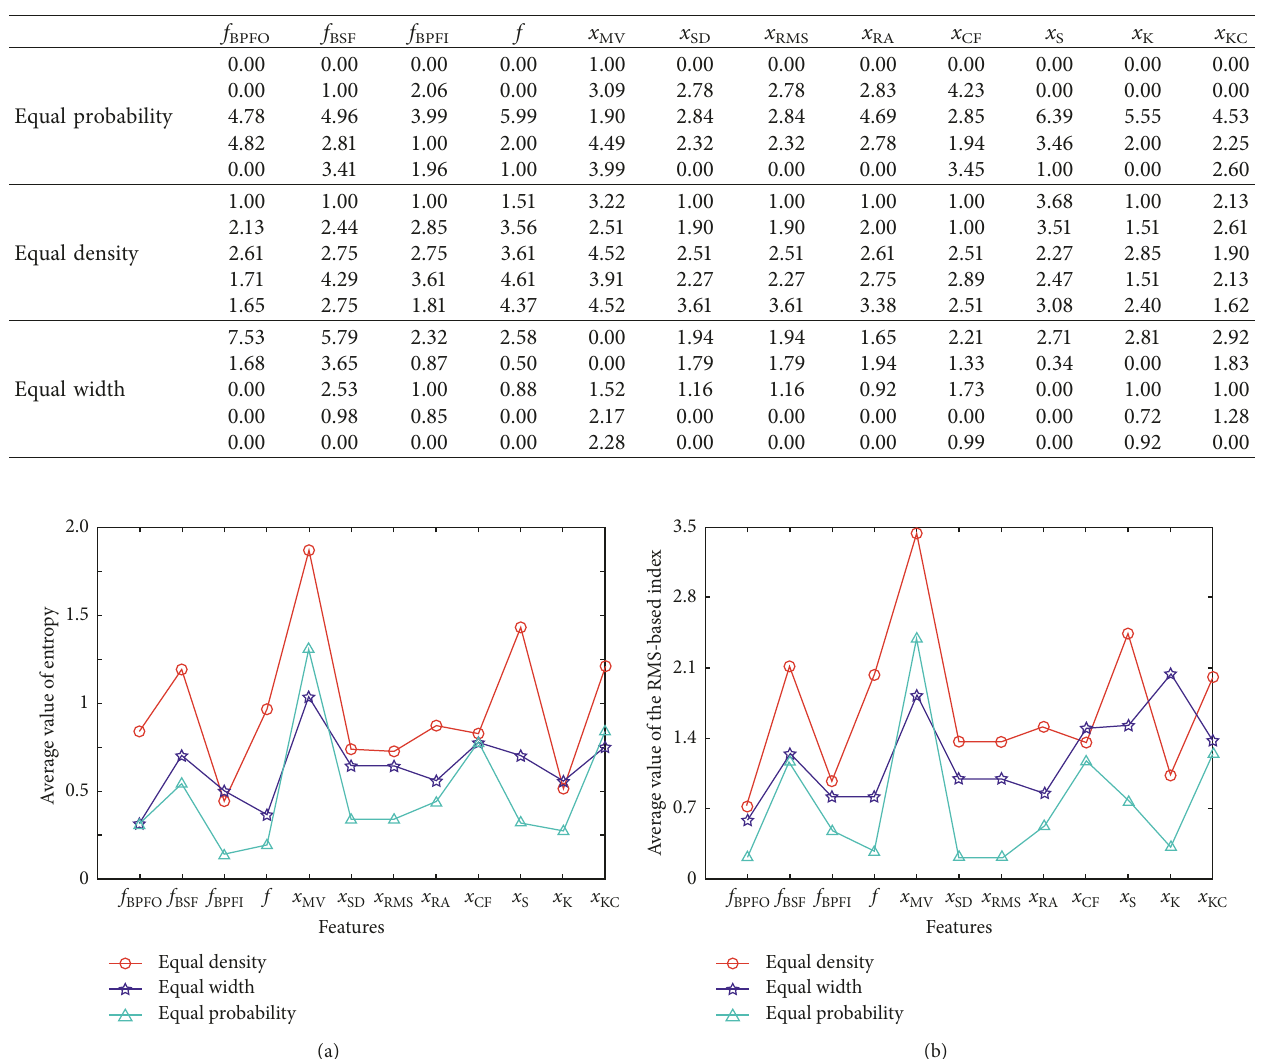
Table 3: The indicator of the RMS-based criteria based on different discretization methods.